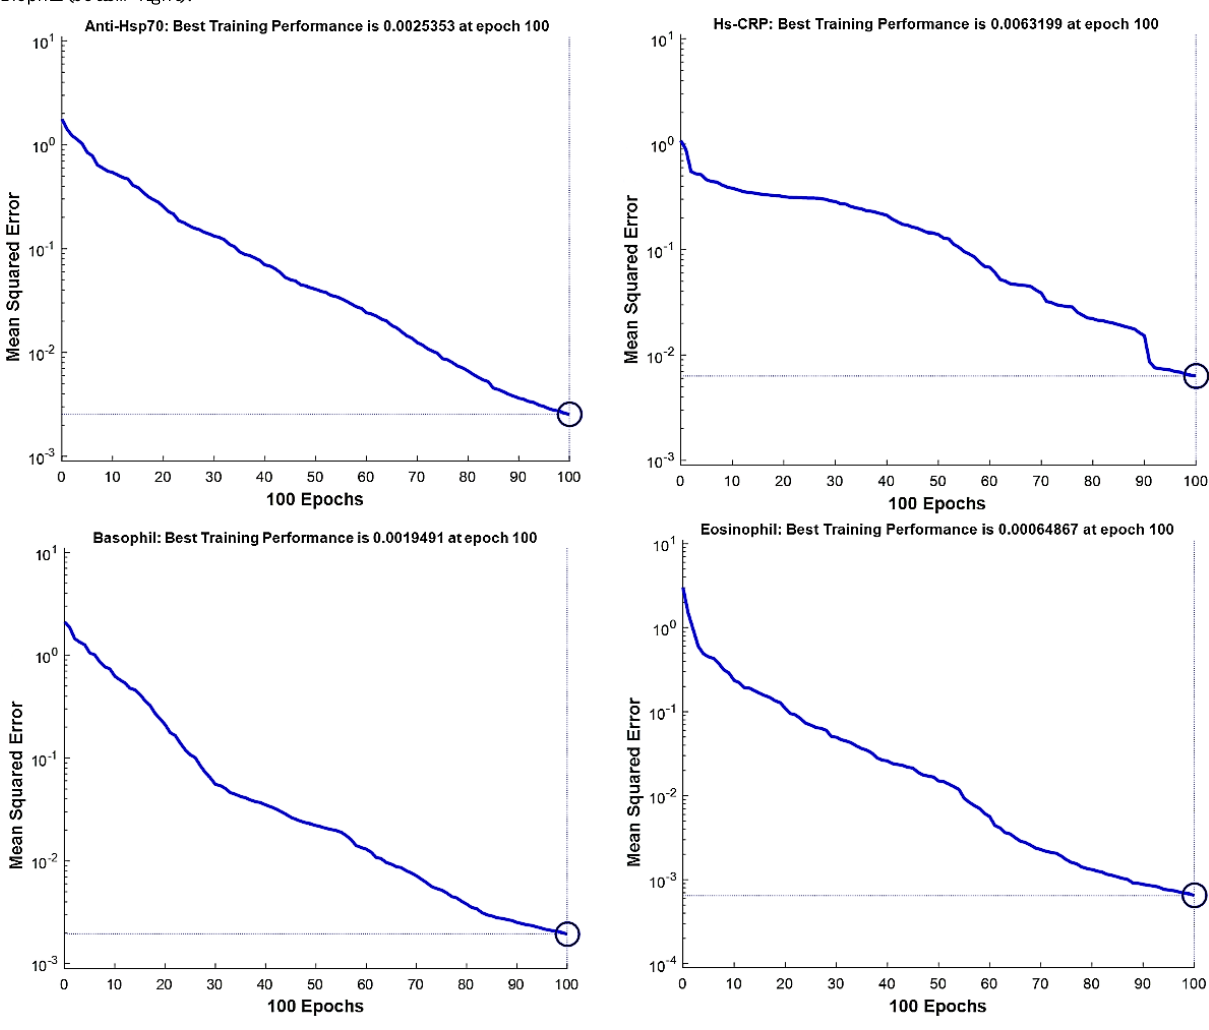
Figure 4. Training performance of the genetic algorithm–modified neural network for C sativus L supplement effects on the anti-inflammatory factors: anti-HSP70 (top left, anti-heat shock protein); hs-CRP (high sensitivity C-reactive protein, top right); and hematologic factors: basophil (bottom left); eosinophil (bottom